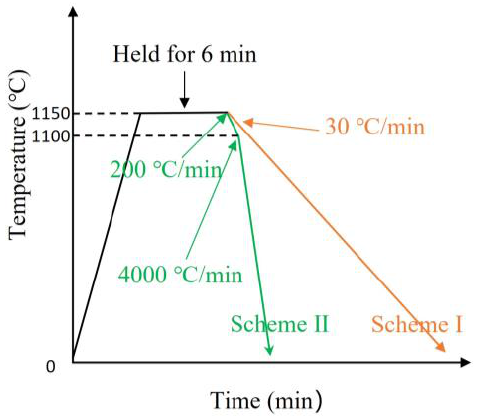
Figure 1. The heat treatment schemes of the in situ experiments.